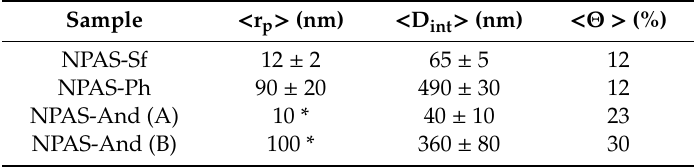
Table 2. Average pore size (<r p >), average interpore distance (<D int >), and average porosity (<Θ >) for the studied NPASs.